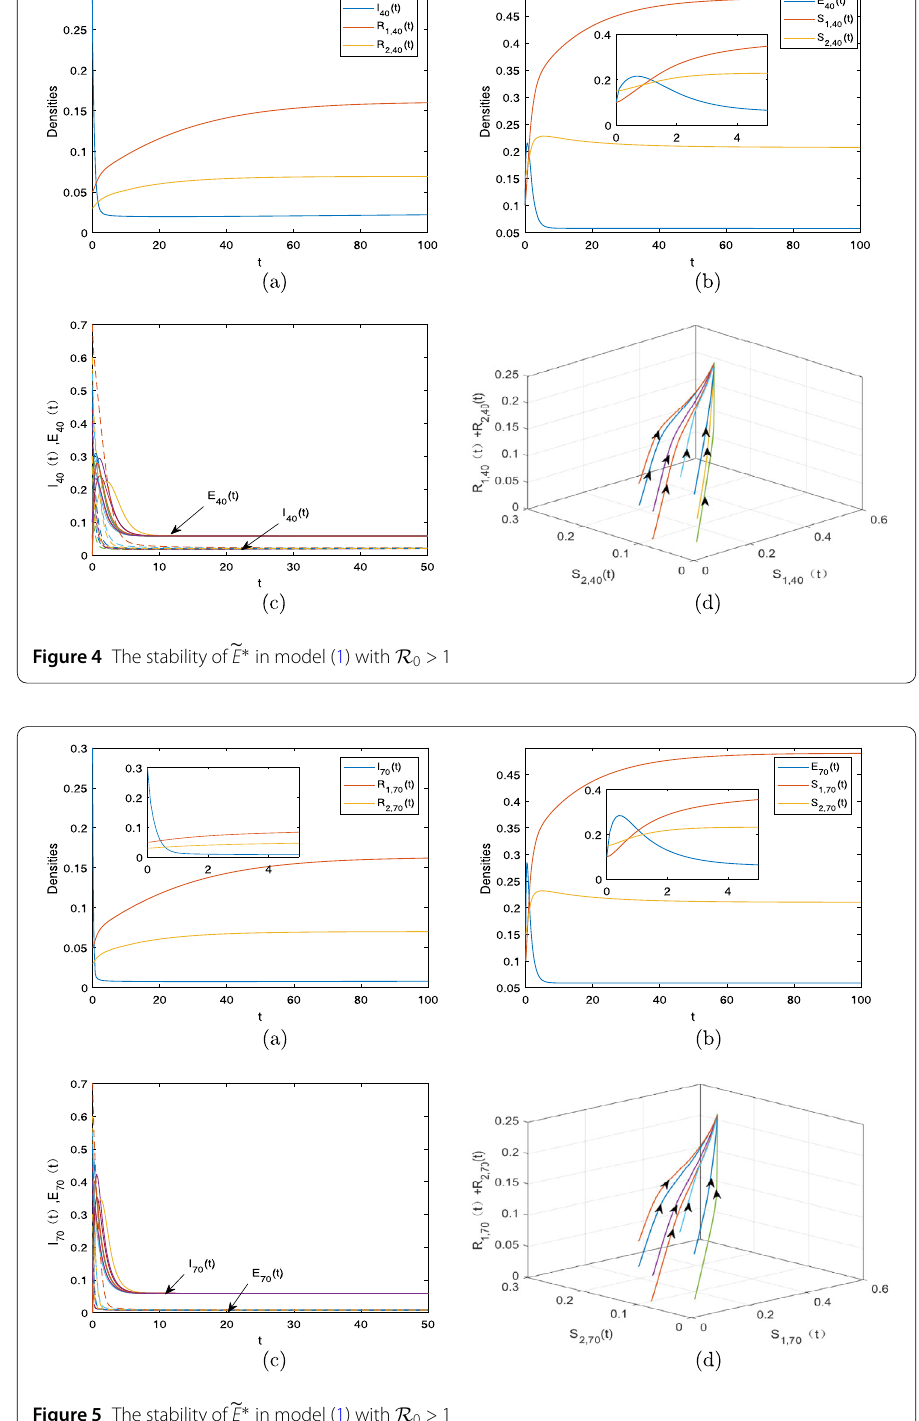
From sensitivity analysis in Sect. 4, it is shown that β , γ , h , δ have an important influence on rumor spreading in model (1). In order to more clearly understand the impact of these parameters for R 0 > 1, an example with some different situations is